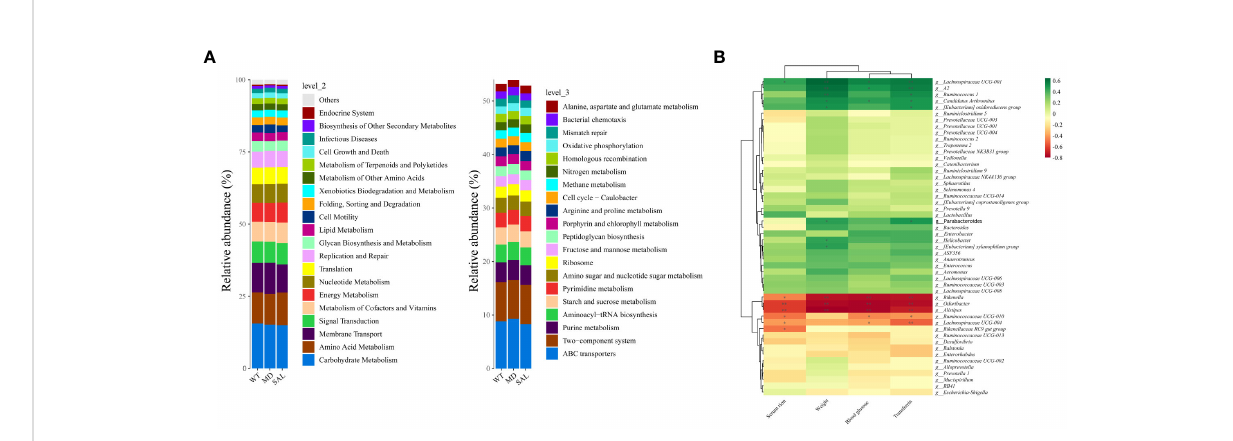
FIGURE 6 Functional prediction and analysis of SAL-related bacteria. (A) , Kyoto Encyclopedia of Genes and Genomes (KEGG) pathways by Tax4Fun tools at level 2 and level 3. (B) , Correlation analysis between high-abundance genera and iron metabolism and glucose metabolism. Color depth indicates correlation, the more red indicates the stronger negative correlation, the more green indicates the stronger positive correlation, and the asterisk indicates signi fi cance (\** p < 0.01; \* p <